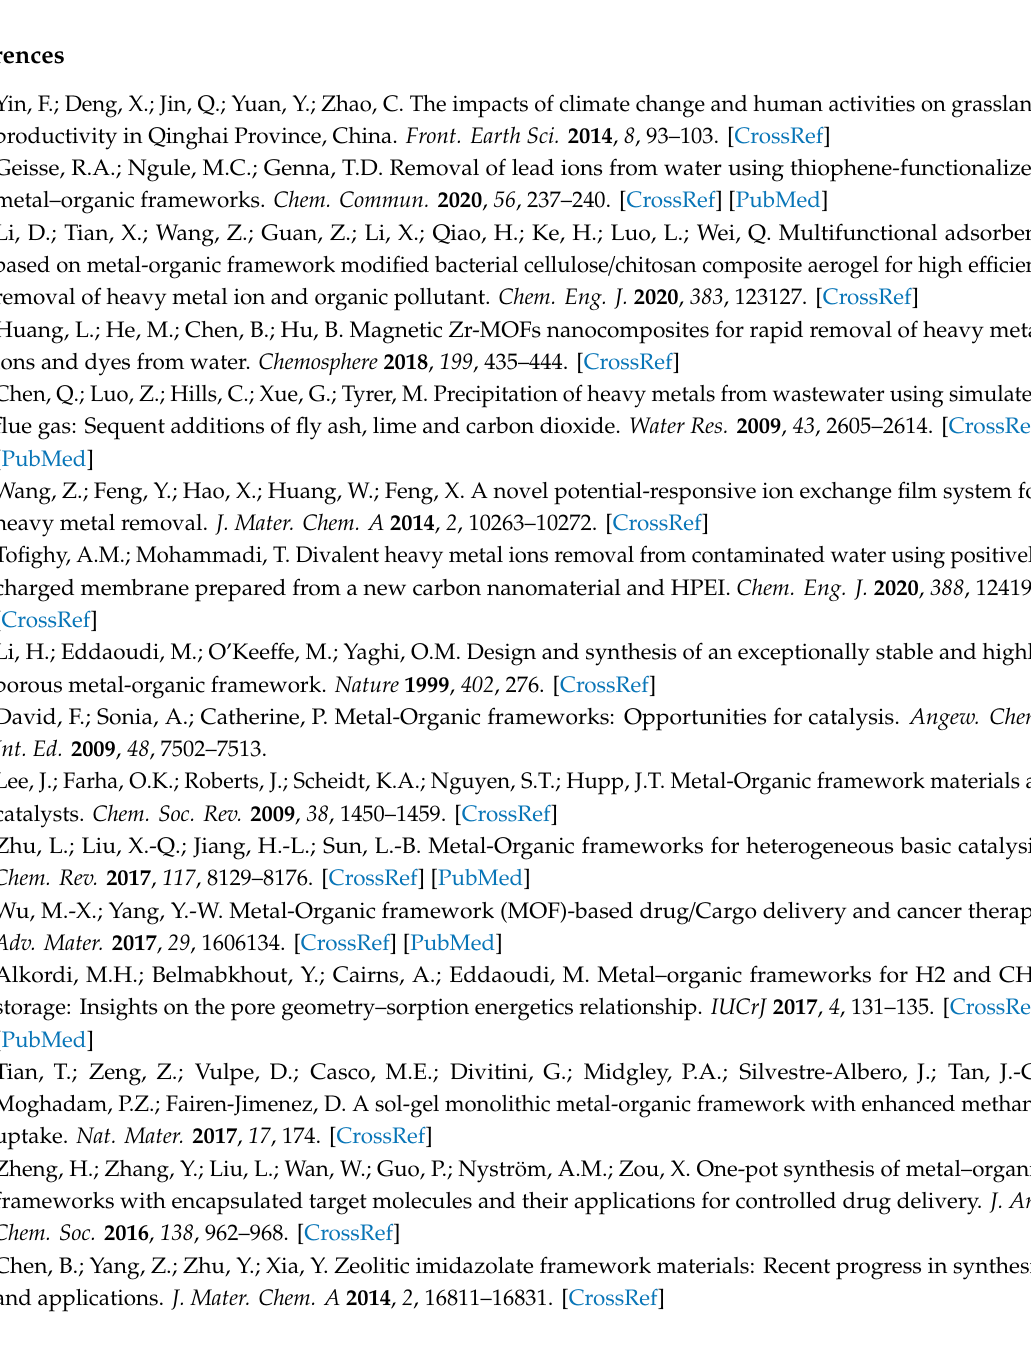
Figure S1: Photograph (inset) and TEM image of MIL-100(Fe)@BC nanocomposite (BTC / Fe(III) = 25), Figure S2: XRD patterns of (a) BC and (b) MIL-100(Fe)@BC nanocomposite (BTC / Fe(III) = 120), Figure S3: Plots of pseudo-first-order kinetics models for the adsorption of As(III) (a) and Rhodamine B (b) using MIL-100(Fe)@BC nanocomposite (BTC / Fe(III) = 120), Figure S4: UV-Vis spectra for the adsorption of Rhodamine B